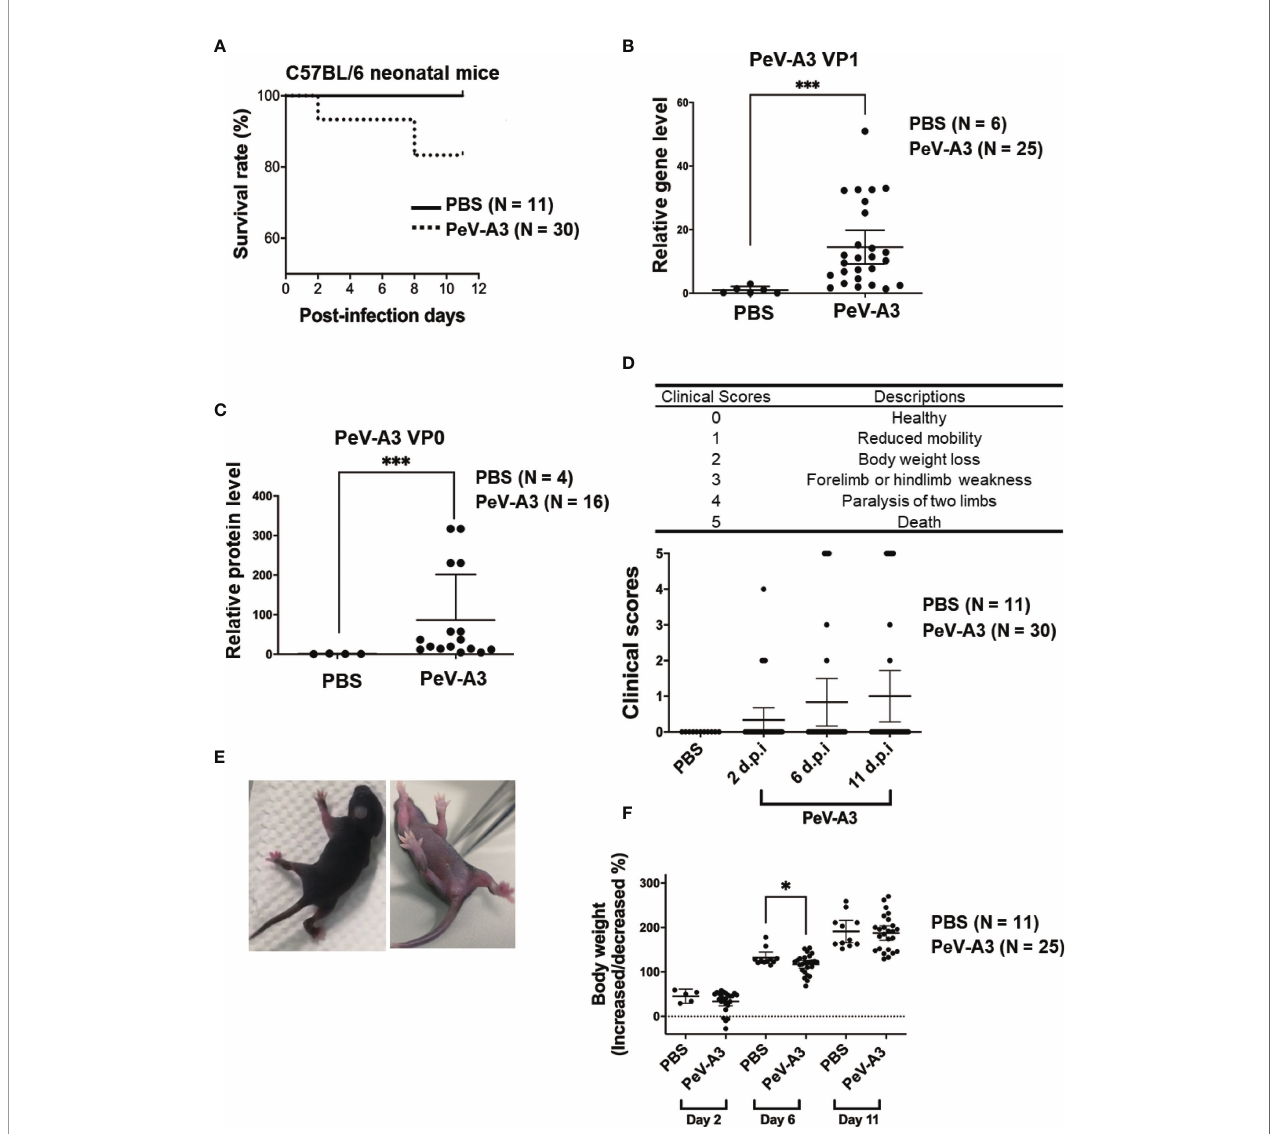
FIGURE 6 | PeV-A3 caused neuronopathic effects in C57BL/6 neonatal mice. (A) Three-day-old C57BL/6 mice were intracranially inoculated with PeV-A3 (5 × 10 5 pfu/mouse) or PBS as mock controls. The survival rate was monitored from days 0 to 11 after inoculation (PBS N = 11, PeV-A3 N = 30). Mann – Whitney U test, *** p < 0.001 compared with PBS controls. (B) Eleven days after inoculation, the mice were sacri fi ced, and total RNA was isolated from brain tissues for PeV-A3 VP1 mRNA detection. Data are mean ± SD, PBS group, N = 6; PeV-A3 group, N = 25. Independent two-sample t-test, p < 0.001 compared with PBS controls. (C) Mouse brain tissue protein lysates were subjected to immunoblotting with anti-PeV-VP0 and anti-GAPDH; the relative expression of PeV-A3 VP0 protein was normalized using GAPDH. PBS controls, N = 4, PeV-A3 N = 16. Independent two-sample t-test, *** p < 0.001 compared with PBS mock control. (D) Description of clinical symptoms corresponded with clinical scores: 0, healthy; 1, reduced mobility; 2, reduced body weight; 3, forelimb or hindlimb weakness; 4, forelimb or hindlimb paralysis; and 5, death. Clinical scores were monitored daily. Clinical score in mice after inoculation at days 2, 6, and 11 were shown. Data are mean ± SD. PBS group, N = 11, PeV-A3 group, N = 30. Independent two-sample t-test. (E) Photo images showed PeV-A3 infection caused paralysis in two limbs at day 2 after inoculation in C57BL/6 mice. (F) Changes in body weight were measured daily. Changes in mice weight after inoculation at days 2, 6, and 11 are shown. Data are mean ± SD, PBS control group, N = 11; PeV-A3, N = 25. Independent two-sample t-test, * p < 0.05 compared with PBS controls. PeV-A3, parechovirus type 3; PBS, phosphate-buffered saline; VP1, viral protein